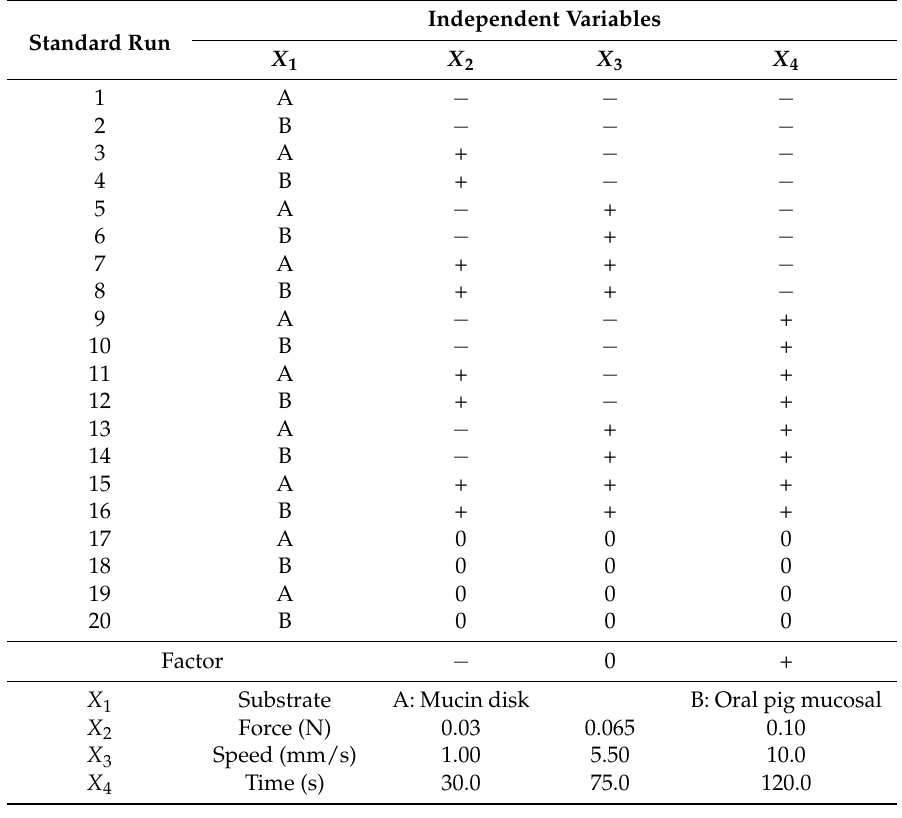
Table 1. Matrix of factorial design 2 4 + 4C for binary polymeric systems composed of 15% ( w / w ) P407 and 0.25% ( w / w ) PCB, at 37 ◦ C, and values for the low and high levels of each variable. Independent Variables Standard Run X